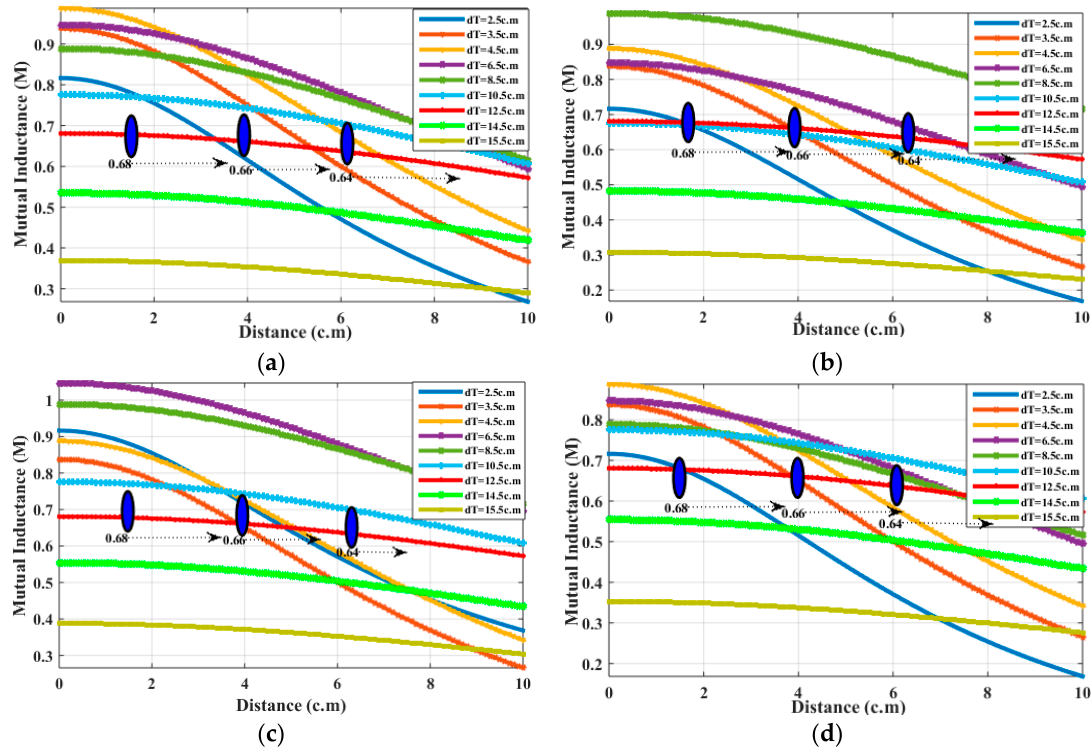
Figure 8. Mutual inductance values for different transmitter diameter ( a ) d R 1 = d R 2 = d R 3 = d R 4 = 4 c.m;